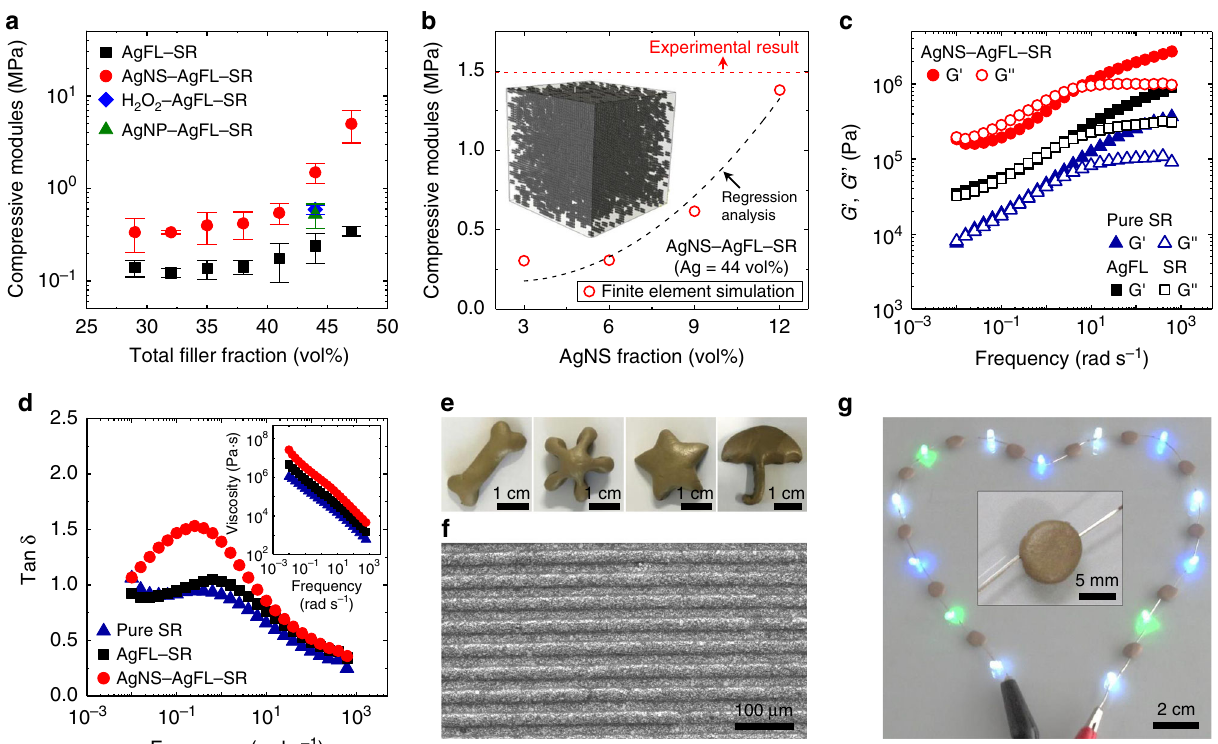
Fig. 6 Mechanical properties and moldability of the AgNS-AgFL-SR nanocomposite. a Compressive modulus of the healable nanocomposites. The error bars represent the standard deviation of the data. b The fi nite element analysis of the AgNS-AgFL-SR nanocomposite as a function of the AgNS particle fraction. The total Ag fi ller fraction was fi xed at 44 vol%. A numerical model (AgNS = 3 vol%) is provided in the inset. The experimentally measured compressive modulus of the AgNS-AgFL-SR (Ag = 44 vol%) nanocomposite is designated by a dashed line. c Storage ( G ’ ) and loss ( G ” ) moduli of the pure SR, AgFL-SR, and AgNS-AgFL-SR nanocomposites as a function of shear strain frequency (shear strain amplitude = 1%, 25 °C). d The tan δ of the pure SR, AgFL-SR, and AgNS-AgFL-SR (Ag = 44 vol%, THF peroxide = 15 mL) nanocomposites. The dynamic viscosity is provided in the inset. e , f Macroscale